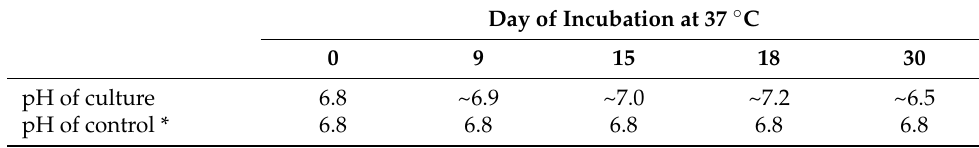
Table 3. Determination of pH in the PZA-S1 medium during the growth of M. tuberculosis